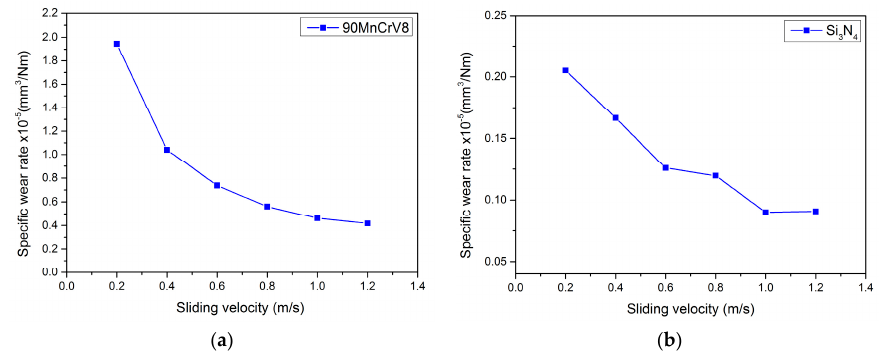
Figure 11. Specific wear rate depending on the sliding velocity: ( a ) 90MnCrV8, ( b ) ceramic ball Si 3 N 4 .